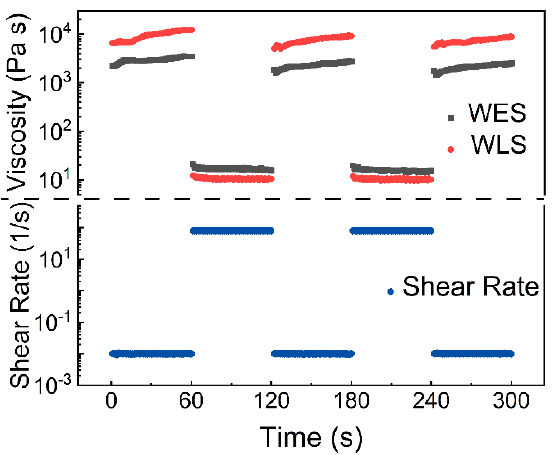
Figure 6. Viscosity variation of WES and WLS in DIW 3D printing condition simulation.